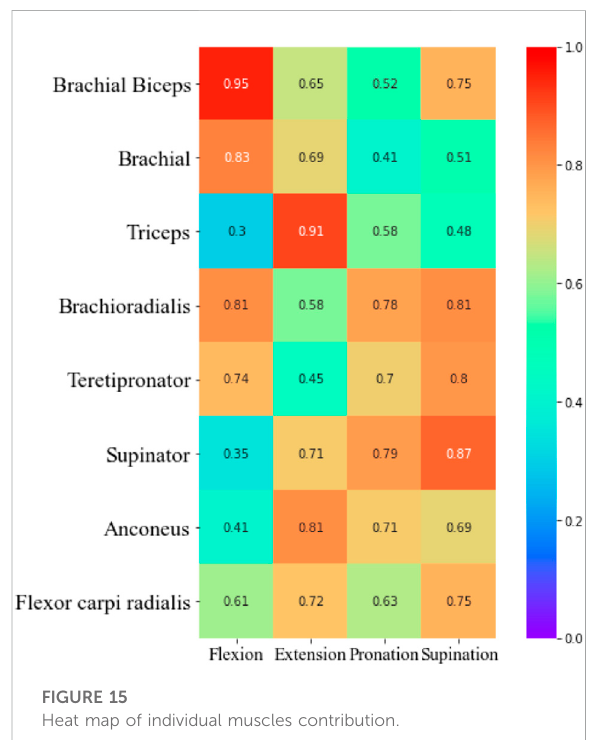
FIGURE 15 Heat map of individual muscles